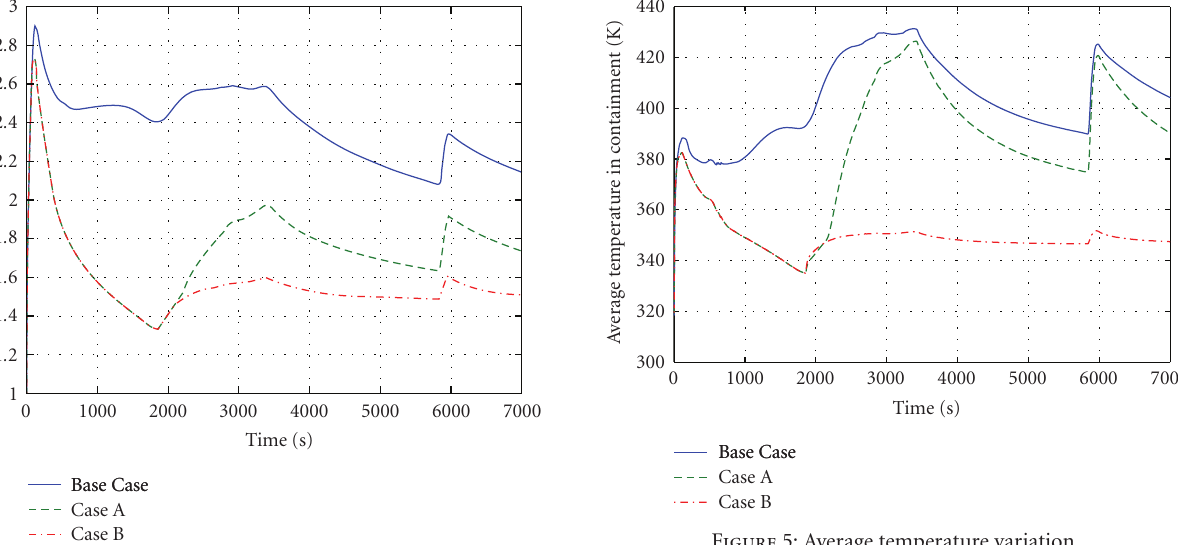
Figure 4: Pressure variation in three cases.